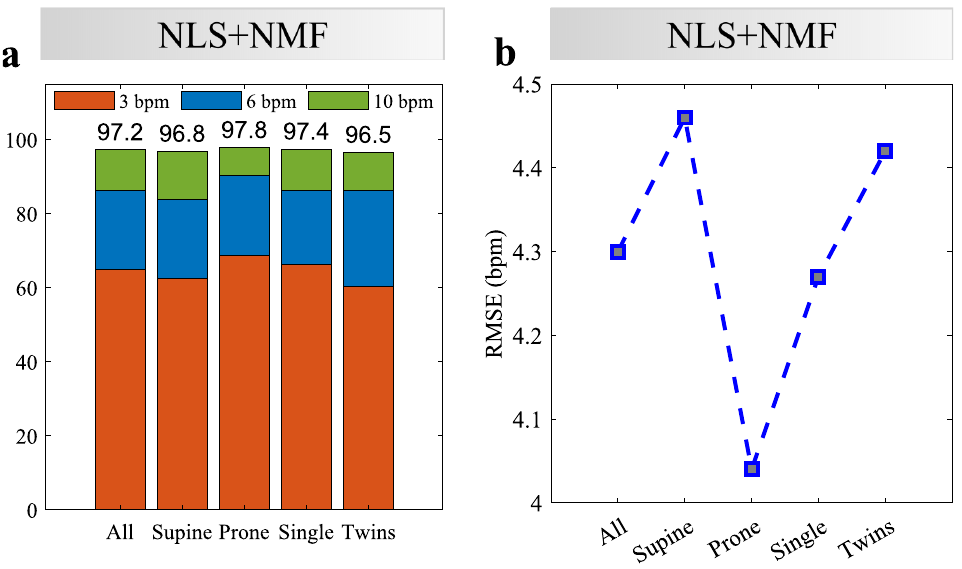
Figure 7. Average performance during minimal movement windows. ( a ) Accuracy for different scenarios. ( b ) Average RMSE for different